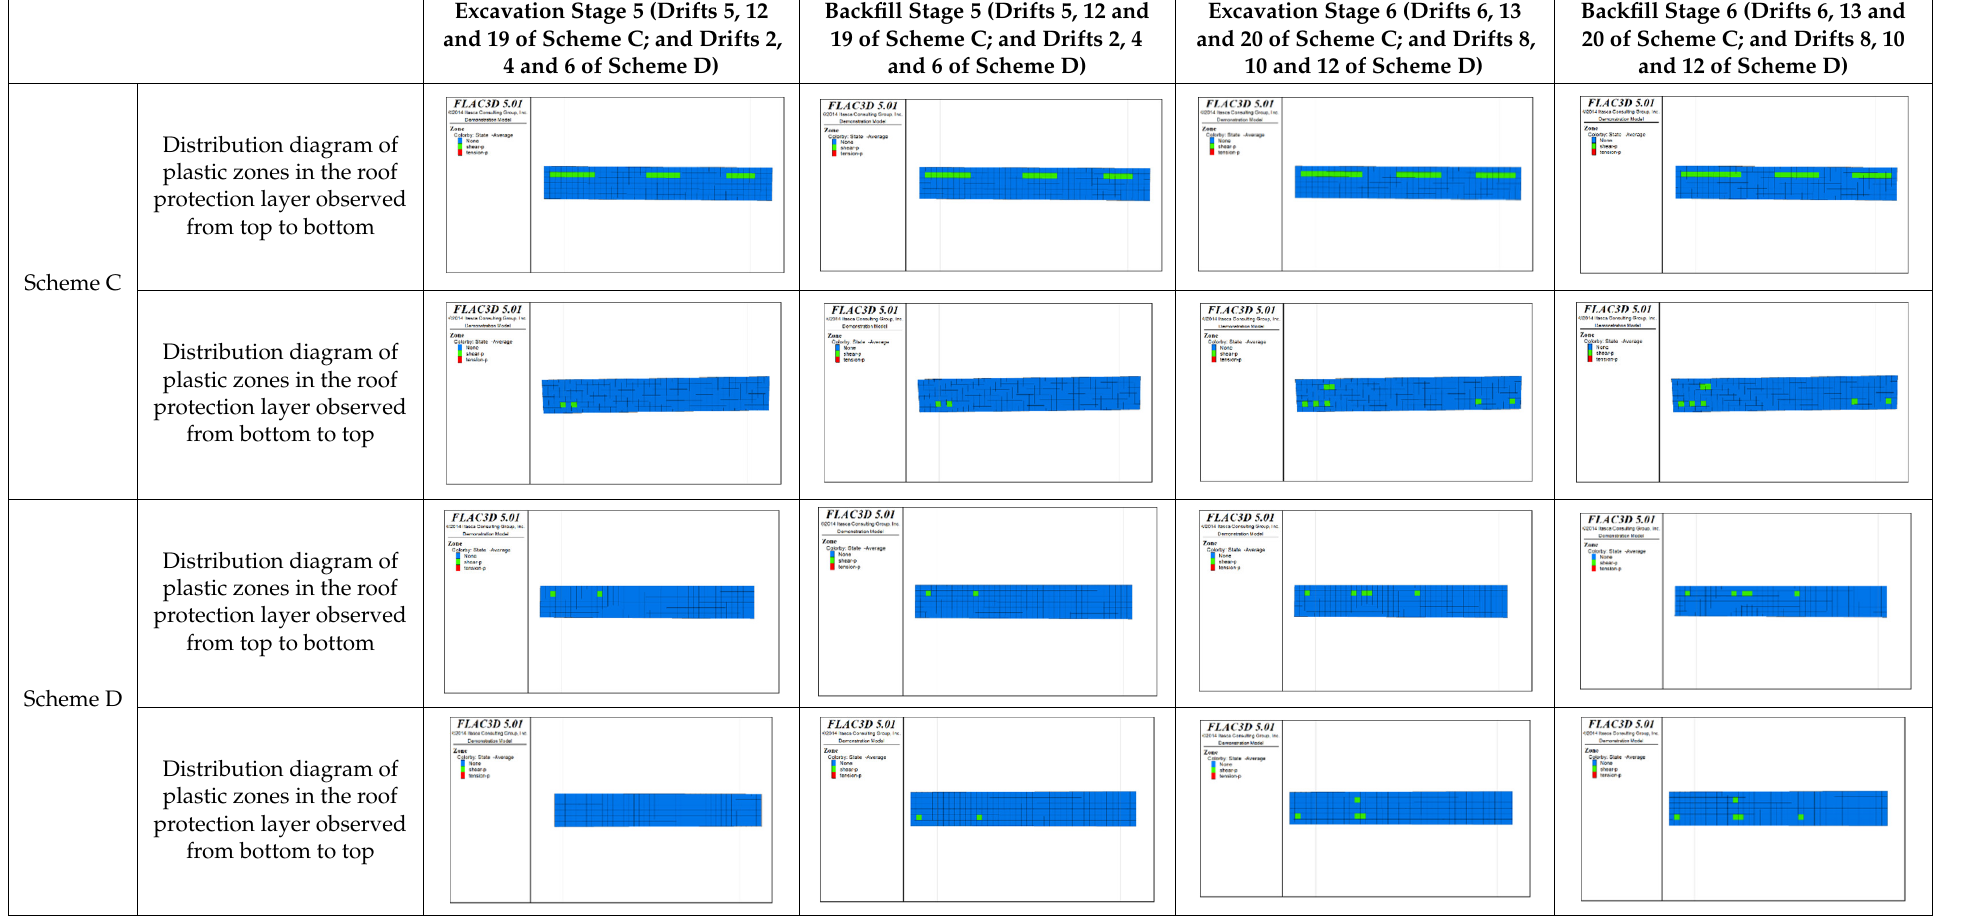
Table 8. Distributions of roof protection layer plastic zones under Schemes C and D (excavation stages 5 and 6).